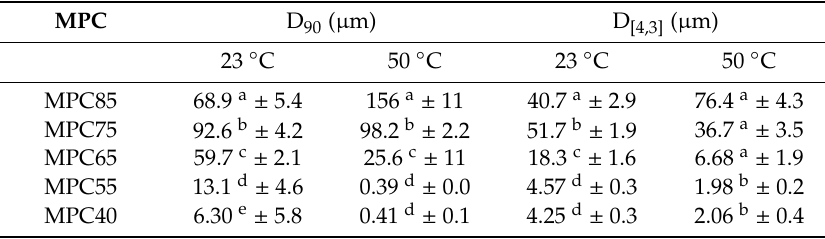
Table 4. Mean particle size of milk protein concentrate (MPC) dispersions after high speed mixing at 23 ◦ C and 50 ◦